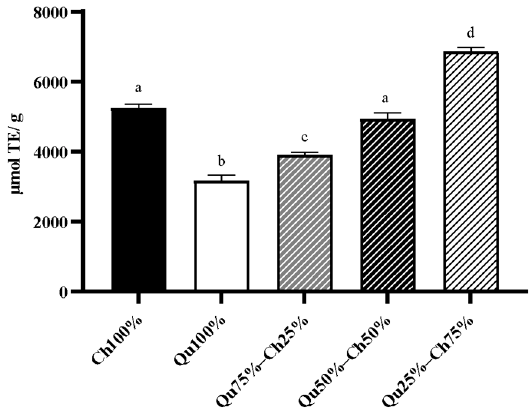
Figure 1. Antioxidant capacity of Ch100%, Qu100%, Qu75%–Ch25%, Qu50%–Ch50%, and Qu25%–Ch75% (100 mg/mL). Data are presented as lsmeans ± SEM ( n = 3). The different superscript letters indicate a significant difference at p < 0.05 (one-way ANOVA). 2000 µM Trolox was included as an internal control.